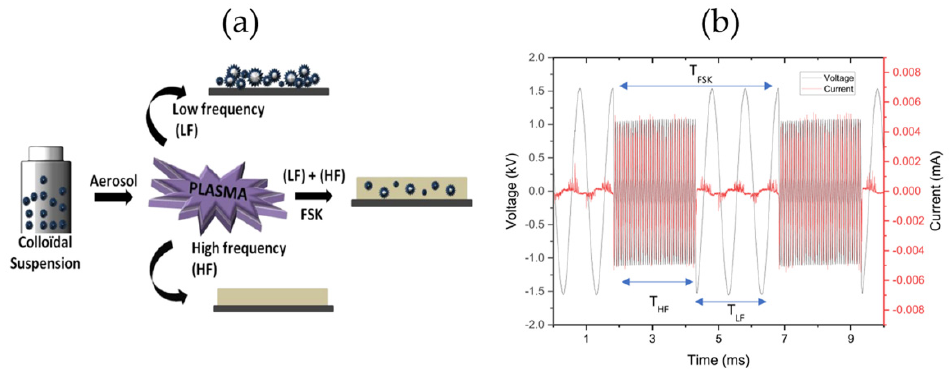
Figure 6. ( a ) Schematic representation summarizing the influence of the frequency of the sinusoidal voltage applied to the electrodes of a parallel-plate DBD system during the deposition of NC coatings from a dispersion of preformed NPs in a liquid precursor: low-frequency (LF) excitation voltage, high-frequency (HF) excitation voltage, and frequency-shift keying (FSK) modulation alternating a high-frequency and a low-frequency voltage. Reproduced with permission from [128]. ( b ) Example of a frequency-shift keying (FSK) double modulation oscillogram with frequencies of 1 kHz (LF) and 15 kHz (HF), a 50% duty cycle, and T FSK of 5 ms. The high-frequency voltage is applied for 2.5 ms (T HF ), and the low-frequency voltage is applied for 2.5 ms (T LF ). Reproduced with permission from [129].